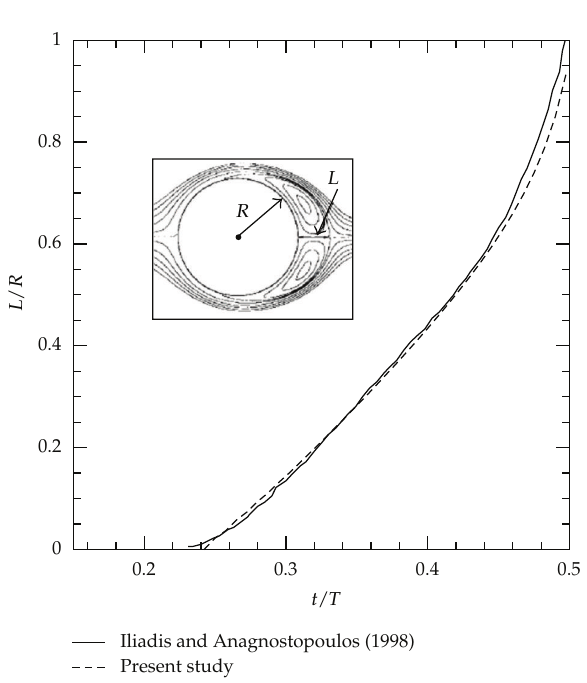
Figure 3: Evolution of wake during half a cycle at KC (cid:8) 2 and Re (cid:8) 200.